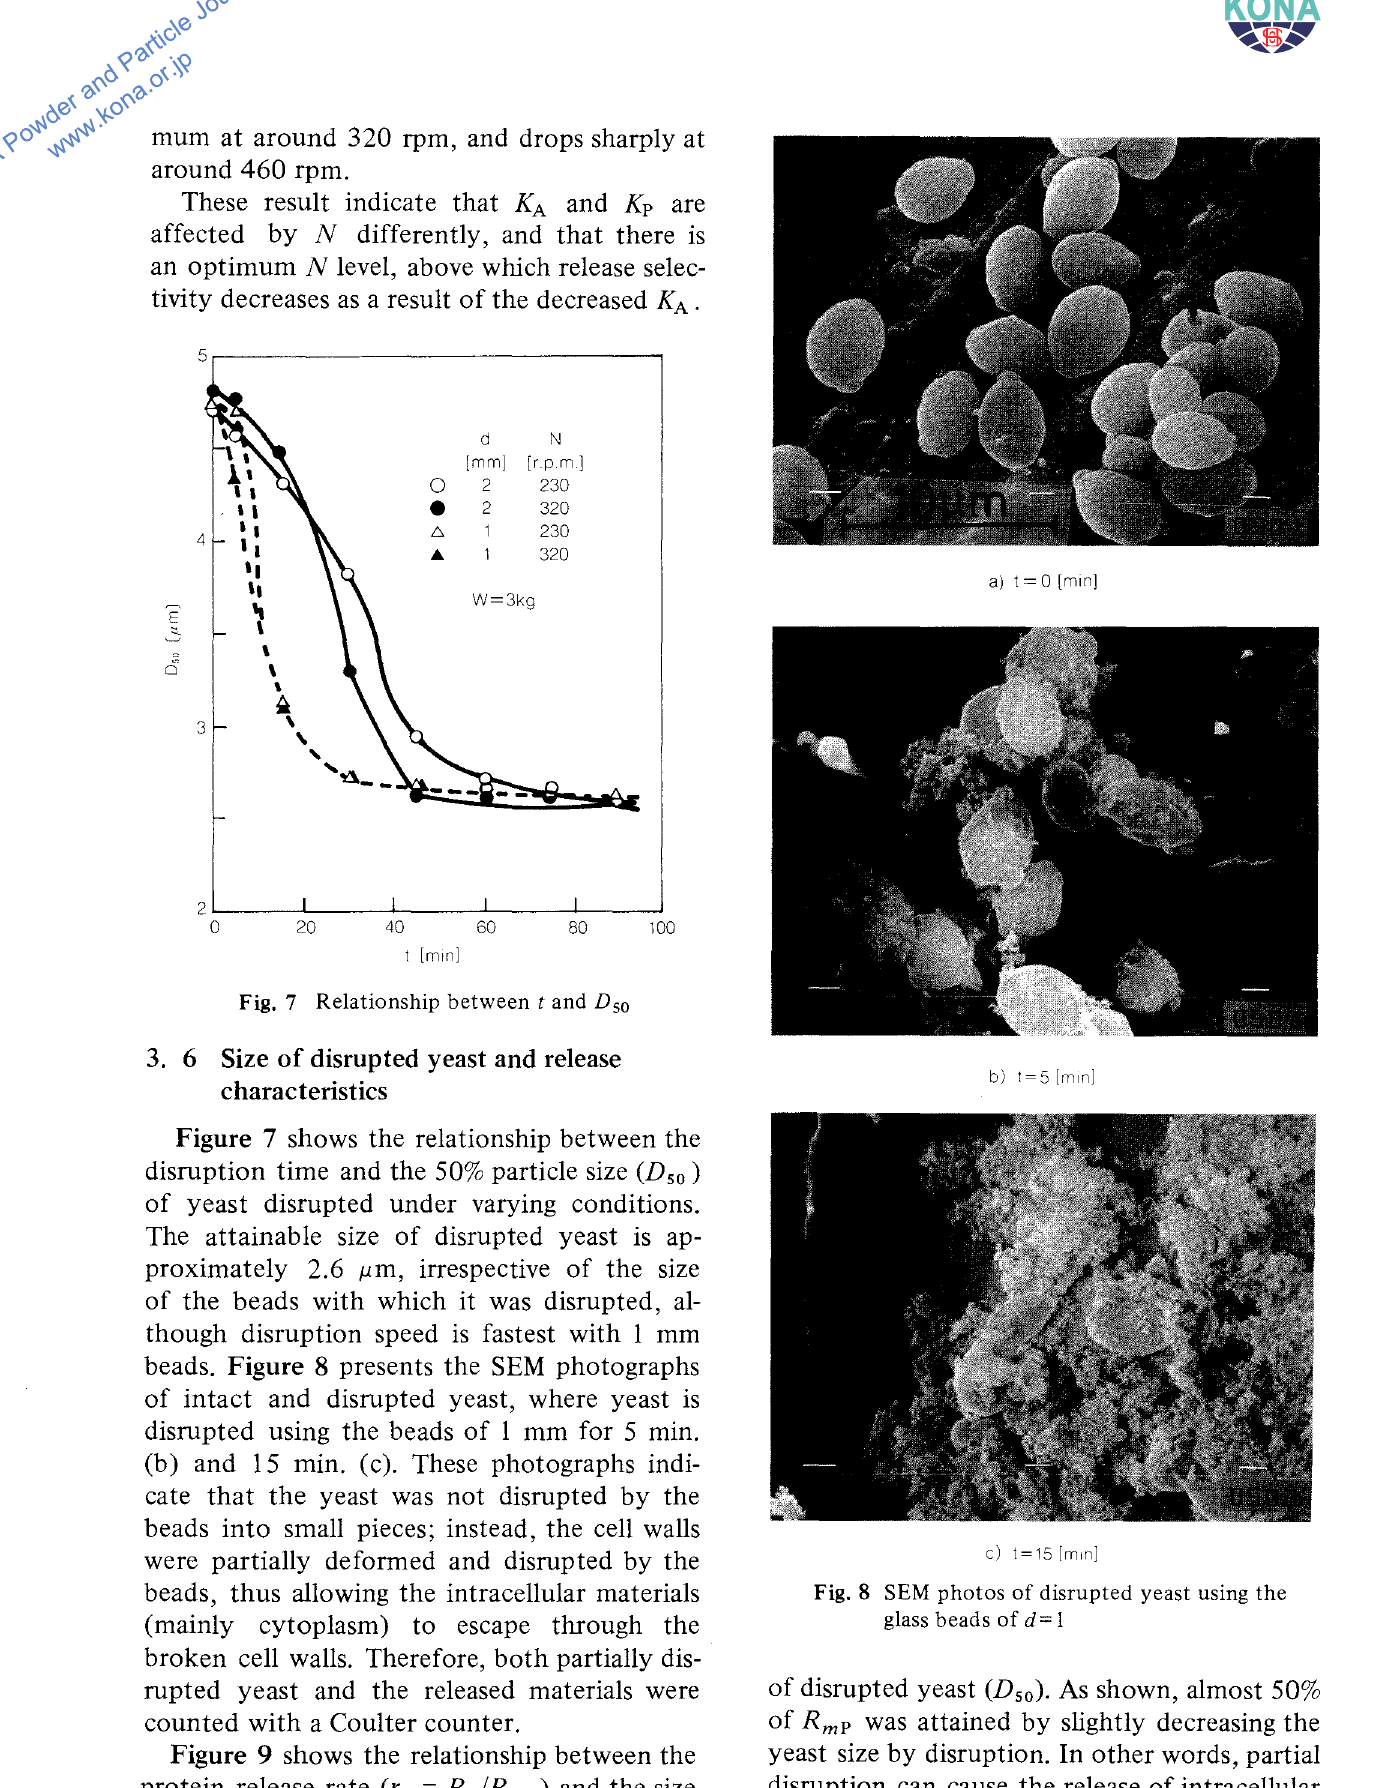
Fig. 8 SEM photos of disrupted yeast using the glass beads of d=